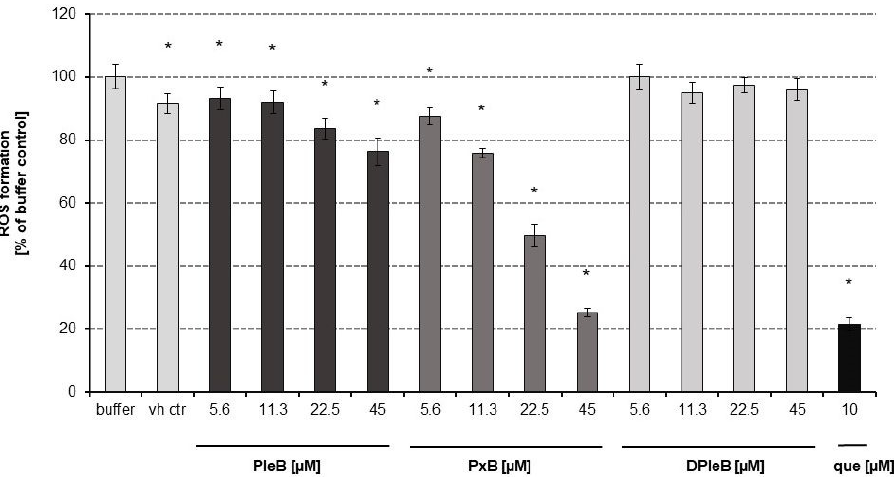
Figure 2. ROS formation in Caco-2 cells. Inhibition of peroxyl radical-induced formation of ROS in cells treated with either quercetin (que, 10 µ M), increasing concentrations of PBs PleB, PxB, DPleB (5.6 to 45 µ M) or vehicle control (vh ctrl, 0.2% ( v / v ) EtOH in HBSS buffer). The mean percentages of DCF fluorescence, as a measure of ROS formation, are shown in relation to the buffer control (set to 100%). Results shown are means ± SEM of at least three independent experiments. * p values ≤ 0.05 were considered as significant.